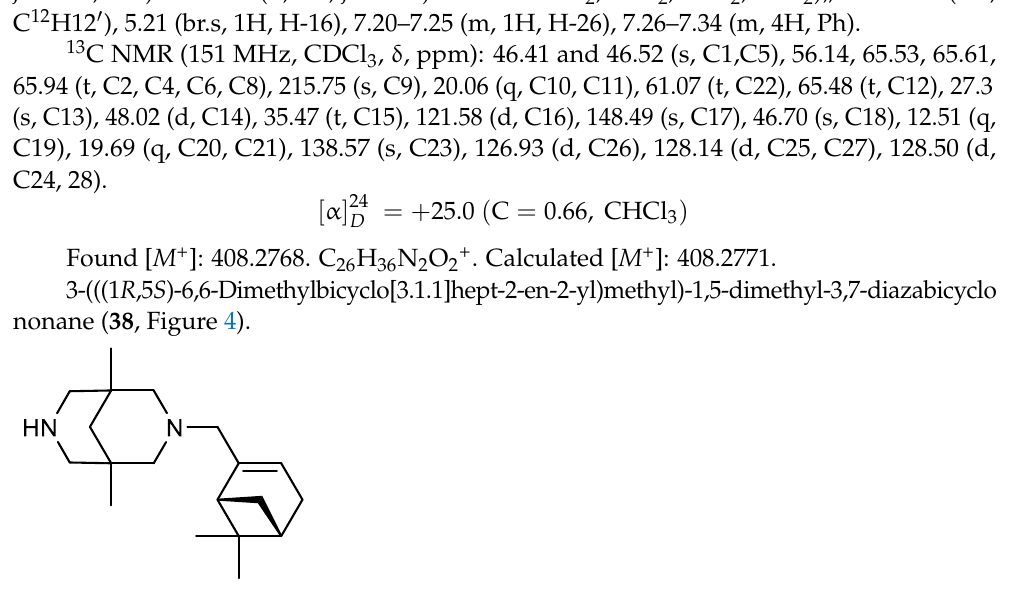
Figure 4. The structure of compound 38 . 214 mg (0.84 mmol) of amine 26 , 190 mg (0.88 mmol) of bromo-derivative 27 , 320 mg of K 2 CO 3 and 5 mL of CH 3 CN were added to the vial for the microwave reactor. The